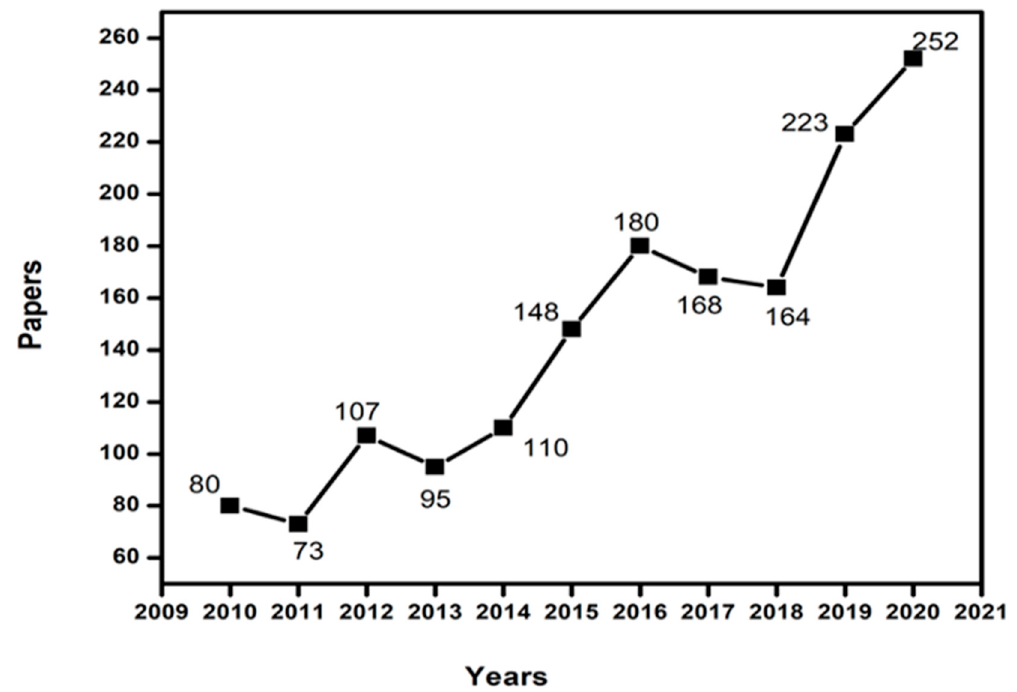
Figure 1. Research trends in the processing of secondary resources by the number of publications per year, 2010–2020. (Source: Scopus. Keywords: recovery of precious metals from spent secondary products and e-waste. The keywords were used to select the relevant articles and the search was limited to 2010 to 2020.).